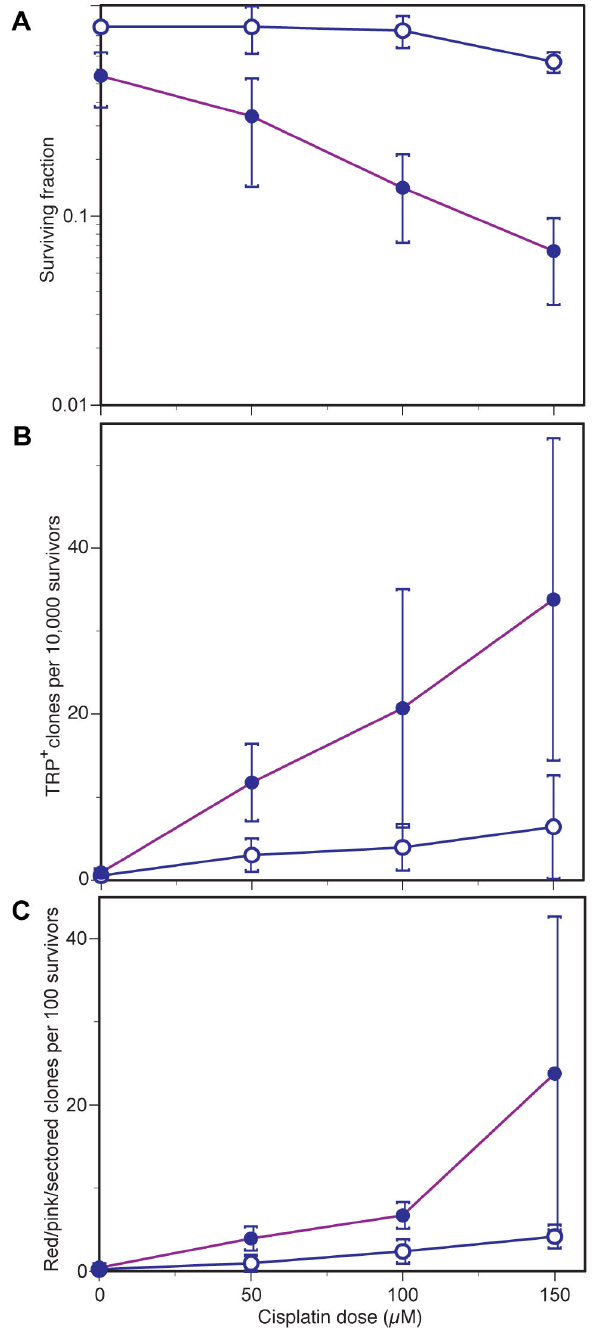
Figure 4. Effect of cisplatin and NSC109268 on survival and induced gene conversion/mitotic recombination in a diploid reporter strain. (A) Surviving fractions of colony forming cells, (B) frequency of TRP + convertants, (C) frequency of red or pink sectored or pure clones of strain D7. Data were plotted as a function of CP dose, administered with or without added NSC109268 (8 µM). Values in B and C were corrected for spontaneous TRP + and red/pink colony background frequencies.